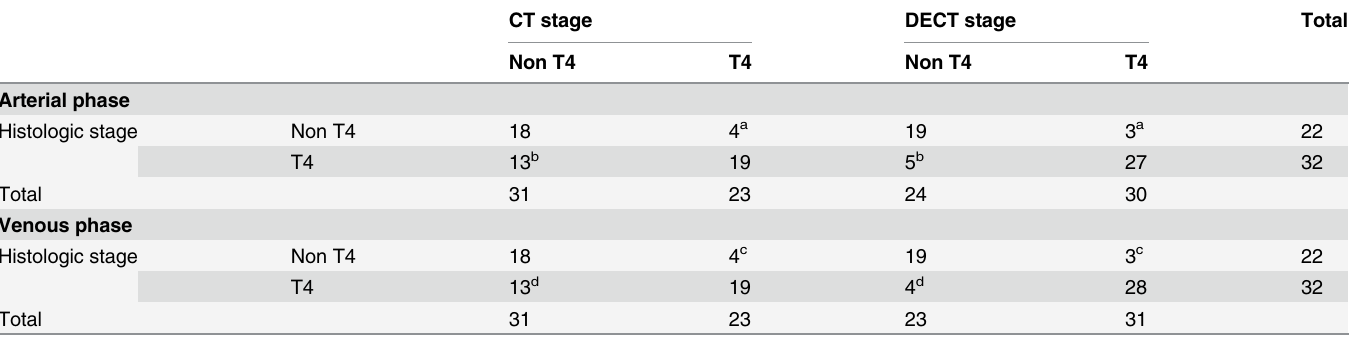
Table 2. T-staging of the gastric cancers using preoperative conventional pre-contrast single-energy CT and dual-energy CT (DECT) compared to postoperative histology staging.